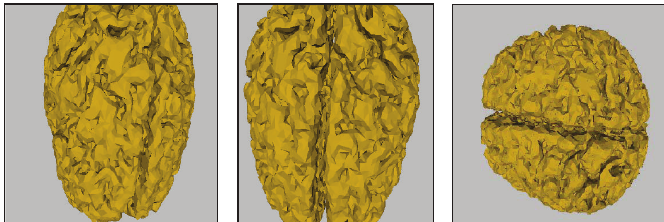
Figure 2: 3D views of the brain used in this study.